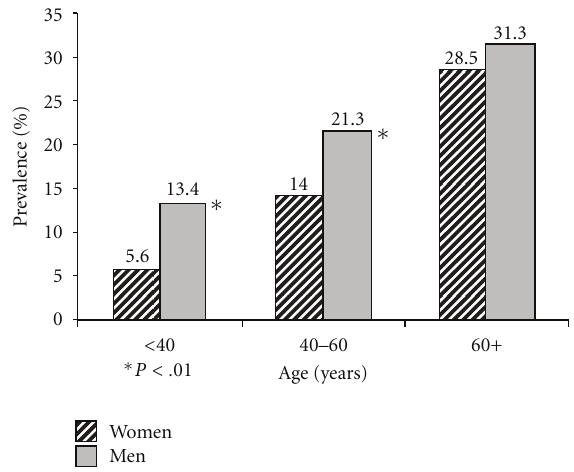
Figure 1: Prevalence of the metabolic syndrome by gender and age.